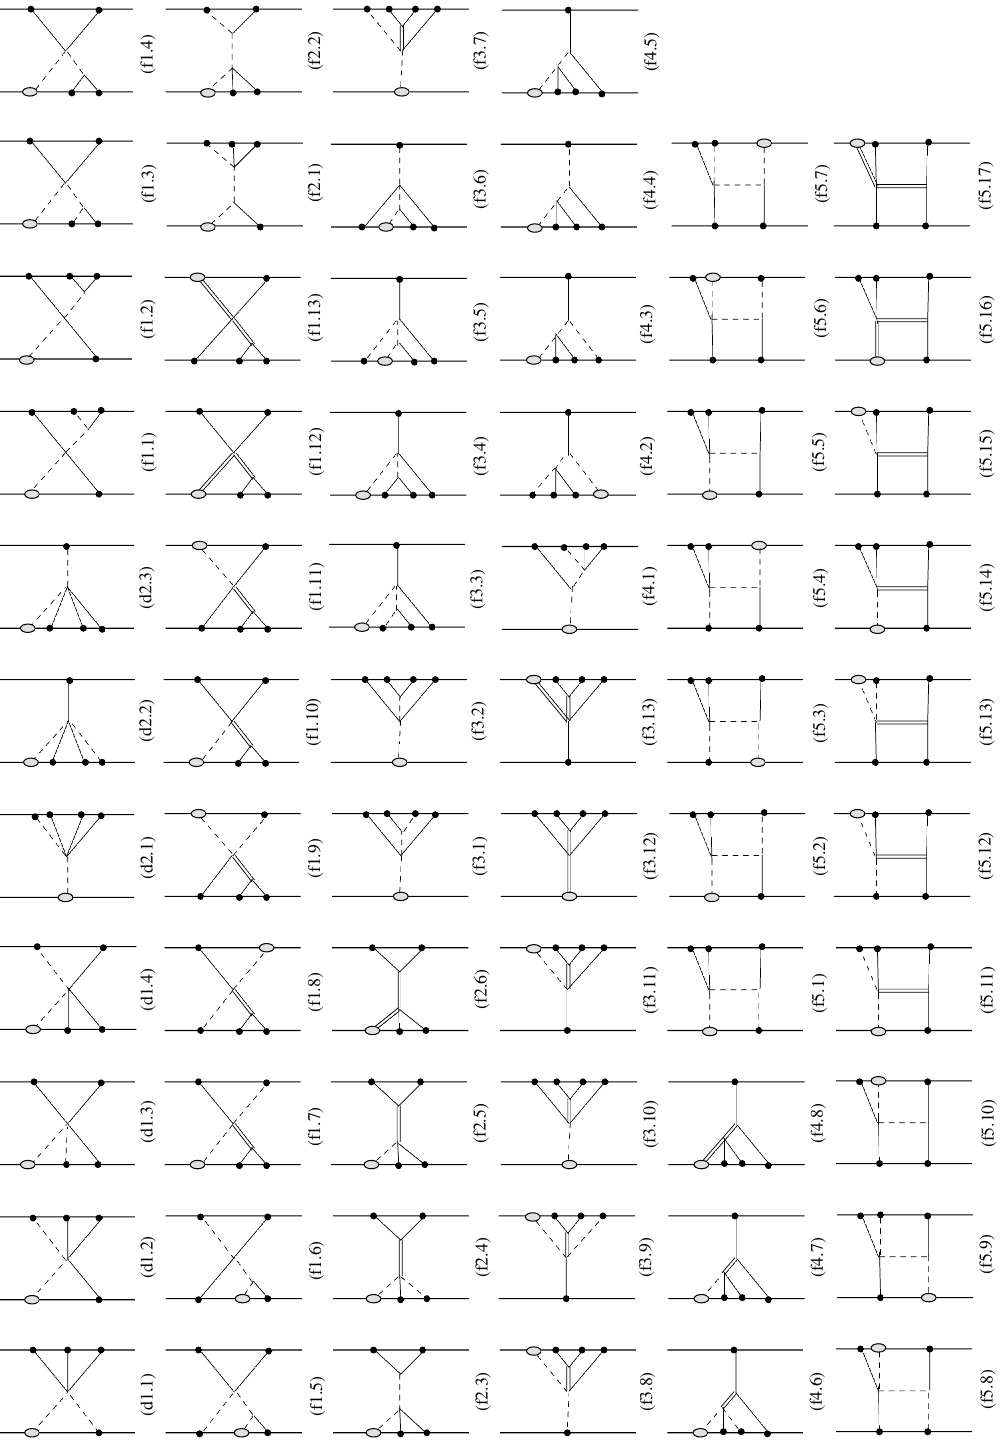
Figure 9 . Feynman graphs which contribute to the N 3 LO spin-orbit coupling at G 4 . This figure contains all graphs with topologies (d) and (f) of figure 4. The graphs in group (f5) are rank-three graphs that require reduction, and appear in the non-spinning sector only at N 4